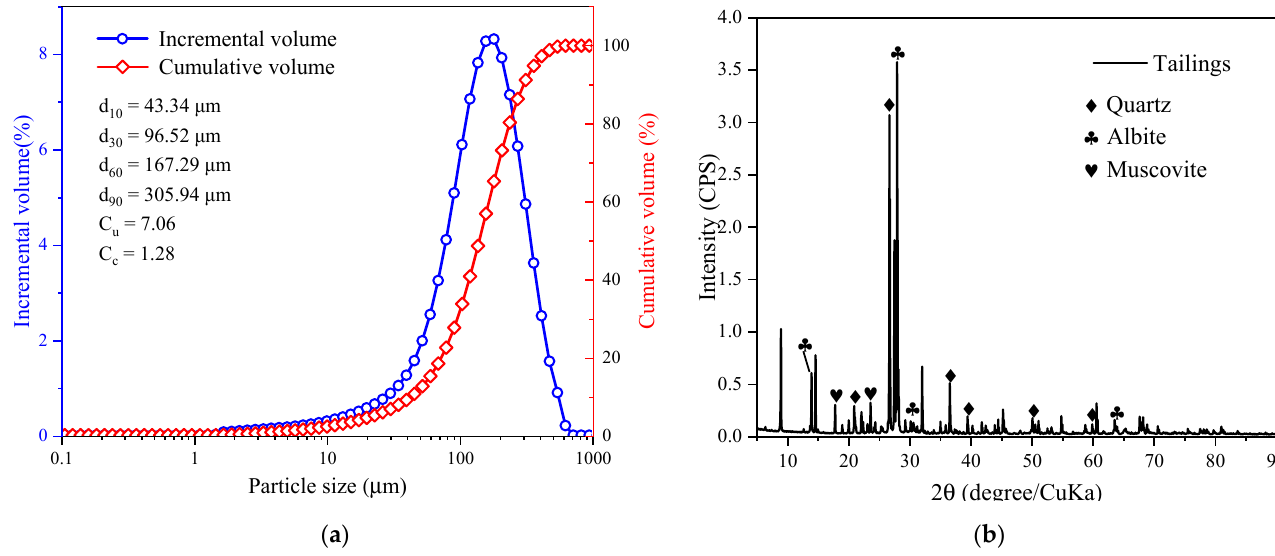
Figure 1. ( a ) Particle size distributions and ( b ) XRD patterns of tailings.